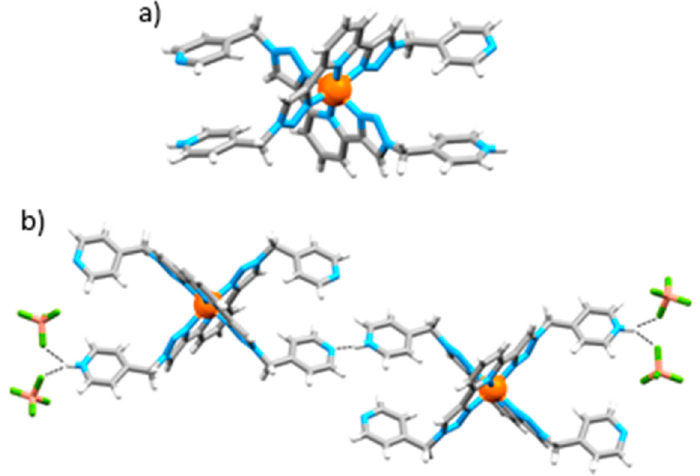
Figure 6. Solid state structure of [Fe( L ) 2 ](BF 4 ) 2 , ( a ) [Fe( L ) 2 (H)] 3+ cation ( b ) hydrogen bonded dimer of [Fe( L ) 2 (H)]. Selected bond lengths (Å): Fe1-N5 = 1.924, Fe1-N6 = 1.969, Fe1-N13 = 1.952, Fe1-N14 = 1.925, Fe1-N4 = 1.954, Fe1-N15 = 1.948, N18-H18A = 1.751, H1A-F6 = 2.254, H1A-F3 = 2.041. Color scheme: carbon, grey; nitrogen, blue; iron, orange; boron, salmon; fluorine, green; hydrogen, white. Sovlent molecules and a BF 4 − anion were omitted for clarity.